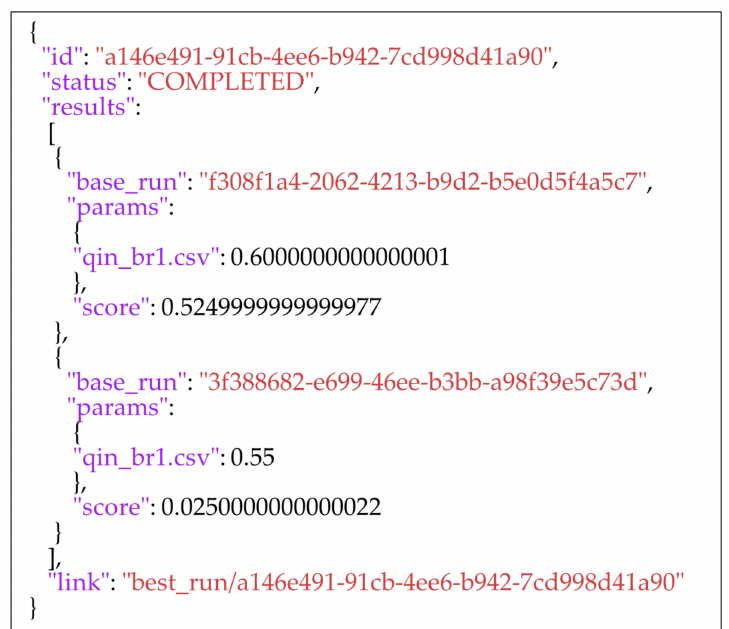
Figure A4. The output of the EDSS. Note: In the first round of simulations (i.e., steps of 0.1 m 3 /s), 0.6 m 3 /s flow had the best score. In the second round of simulations (i.e., steps of 0.01 m 3 /s around 0.6 m 3 /s), 0.55 m 3 /s flow had the best